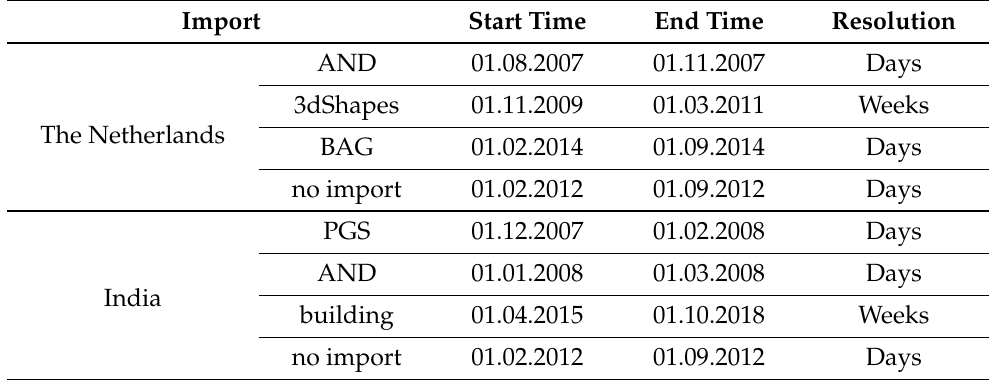
Table 4. Observation period and temporal resolution for the imports. The temporal resolution depended on the duration of the observation period. Intervals longer than 12 months were carried out in weekly resolution, the remainder in daily